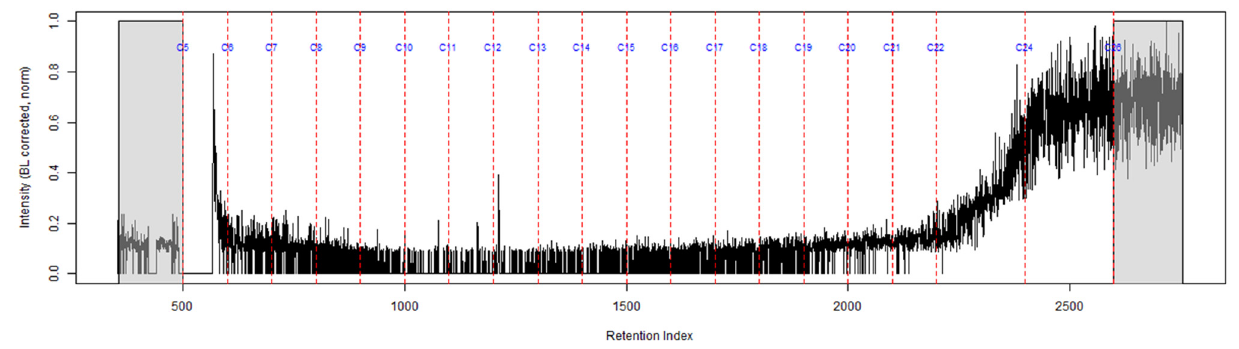
Figure 5. TIC of the extract from the turnout gear within the dosimeter from the can containing 2-min MDDM burned vinyl siding and a railroad tie (maximum peak abundance 2.5 × 10 5 ).